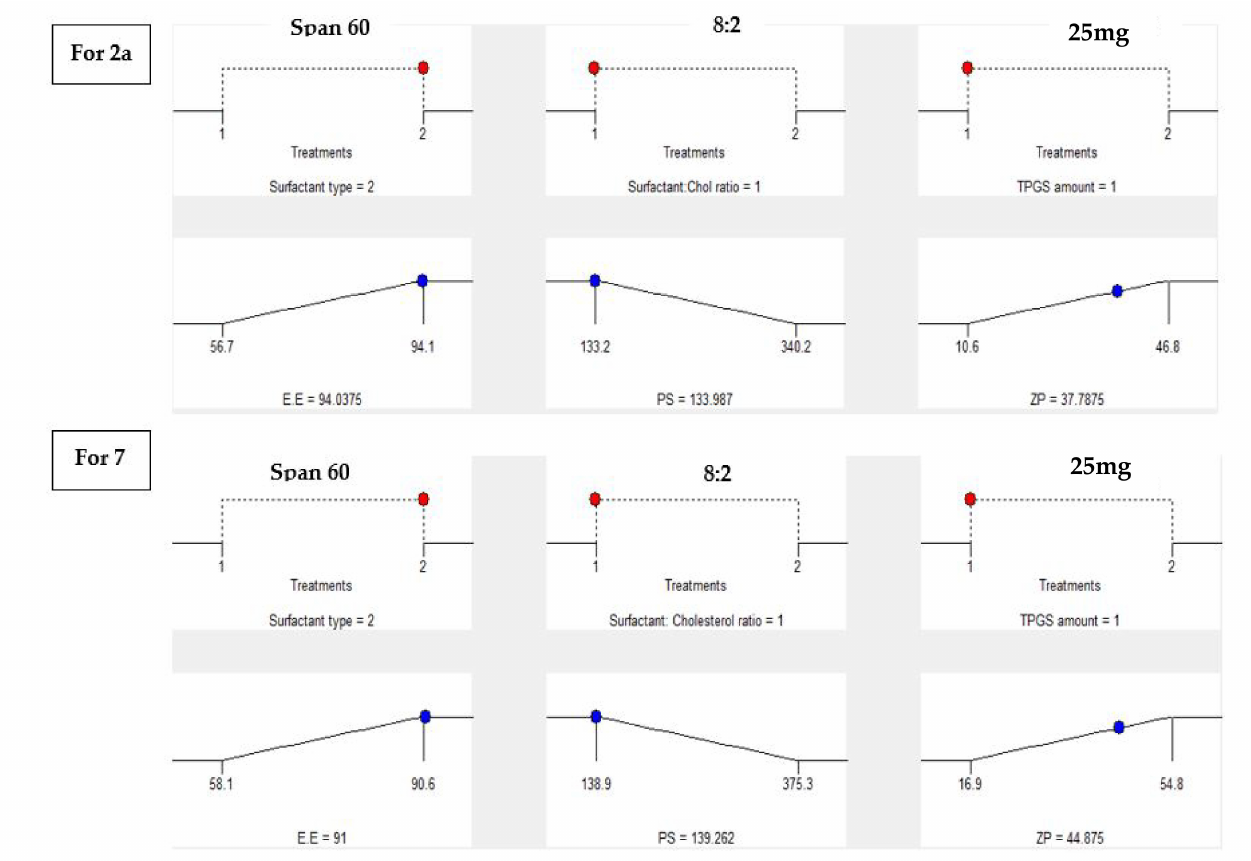
Figure 17. Optimization ramps for the studied independent variables with the predicted value of each measured formulation parameter.